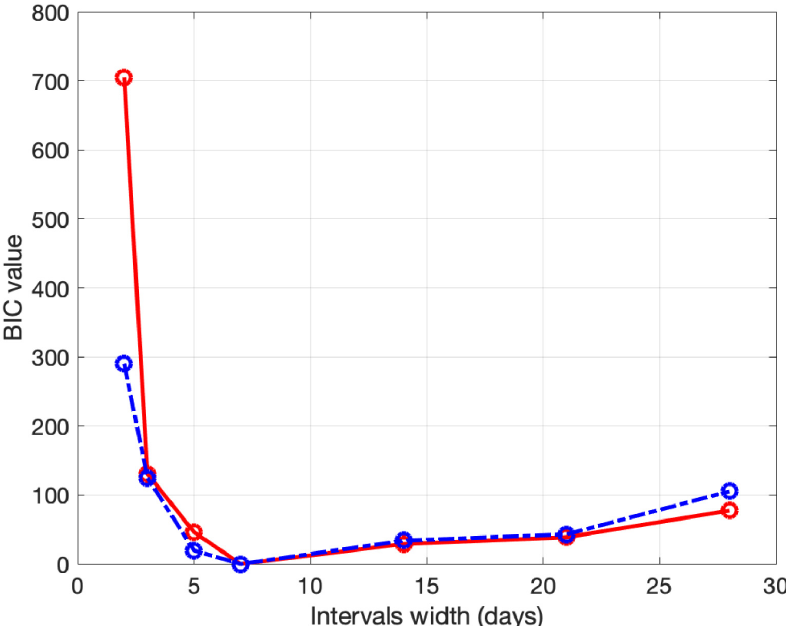
(12) computed for intervals widths {3, 5, i